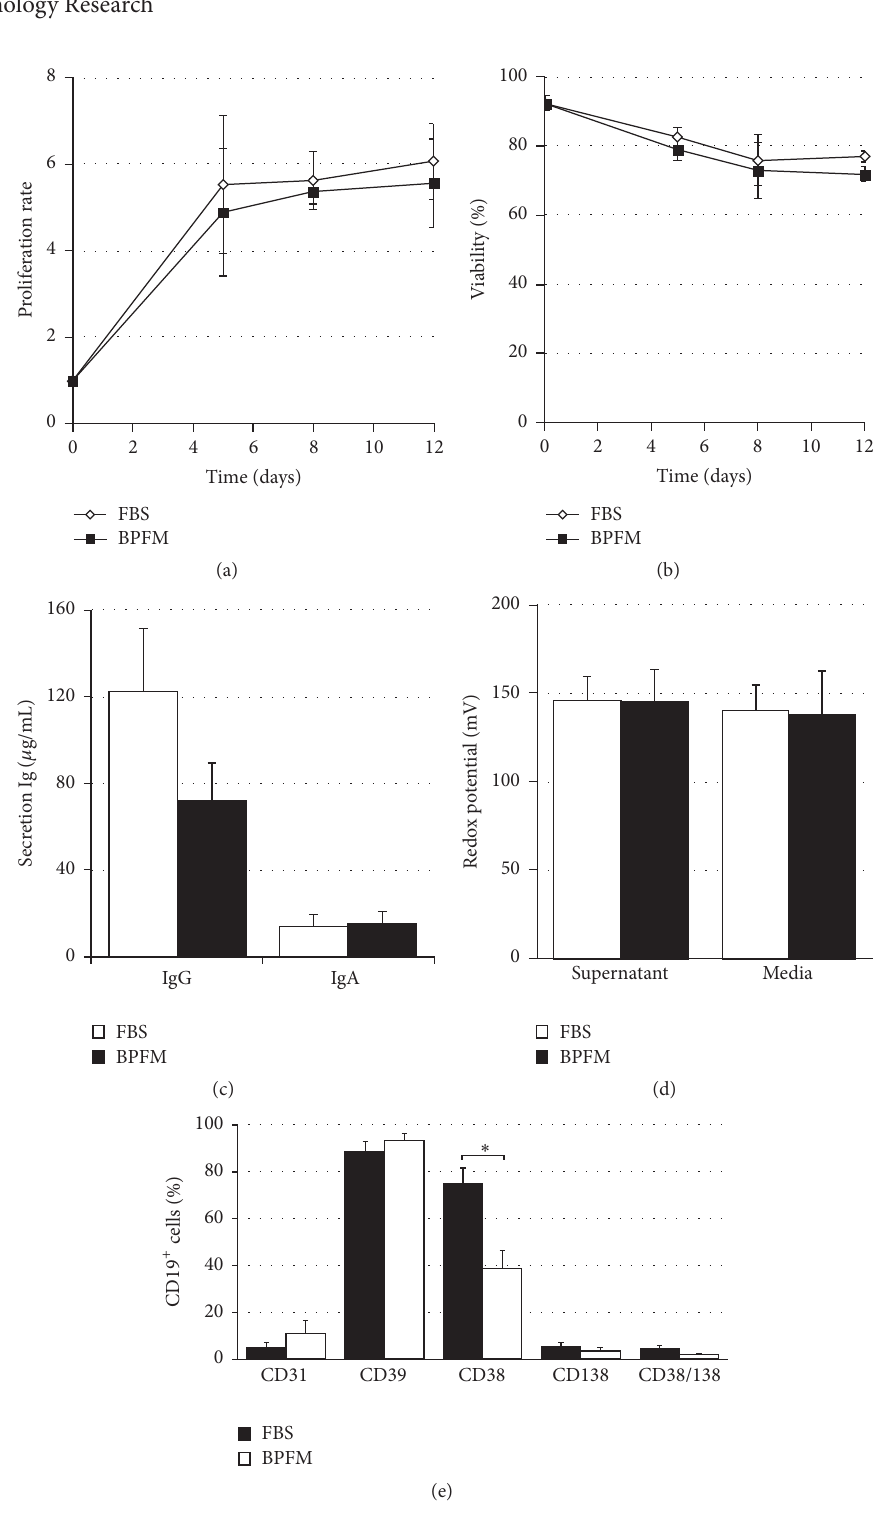
Figure 1: In vitro expansion of switched B lymphocytes in medium containing FBS or in serum-free medium. Five samples of switched memory B lymphocytes were cultured in the presence of IL-2, IL-4, and IL-10 and CD154 + cells (L4.5 cells) at a ratio of five B lymphocytes per L4.5. Cells were cultured in parallel in medium containing FBS or in serum-free medium. (a) and (b) show, respectively, the proliferation rate and viability of B lymphocytes after 12 days of culture. (c) The cells were kept in culture for 9 supplemental days to determine the secretion level of IgG and IgA. (d) Redox potential of cell culture supernatants (day 8) and media was measured on 5 independent samples. (e) The proportions of cells expressing CD38 and CD138 markers were determined on gated CD19 + B lymphocytes on day 12 ( ∗ indicates 𝑝 ≤ 0.05 , unpaired Student’s 𝑡 -test). All data are from 5 independent experiments, except for the monitoring of CD31 and CD39 in (e), which was done on 4 independent samples. Data are presented as means ±